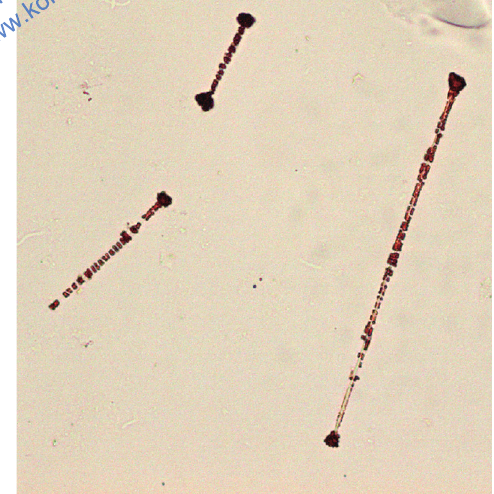
Fig. 2 Light microscope of asbestos